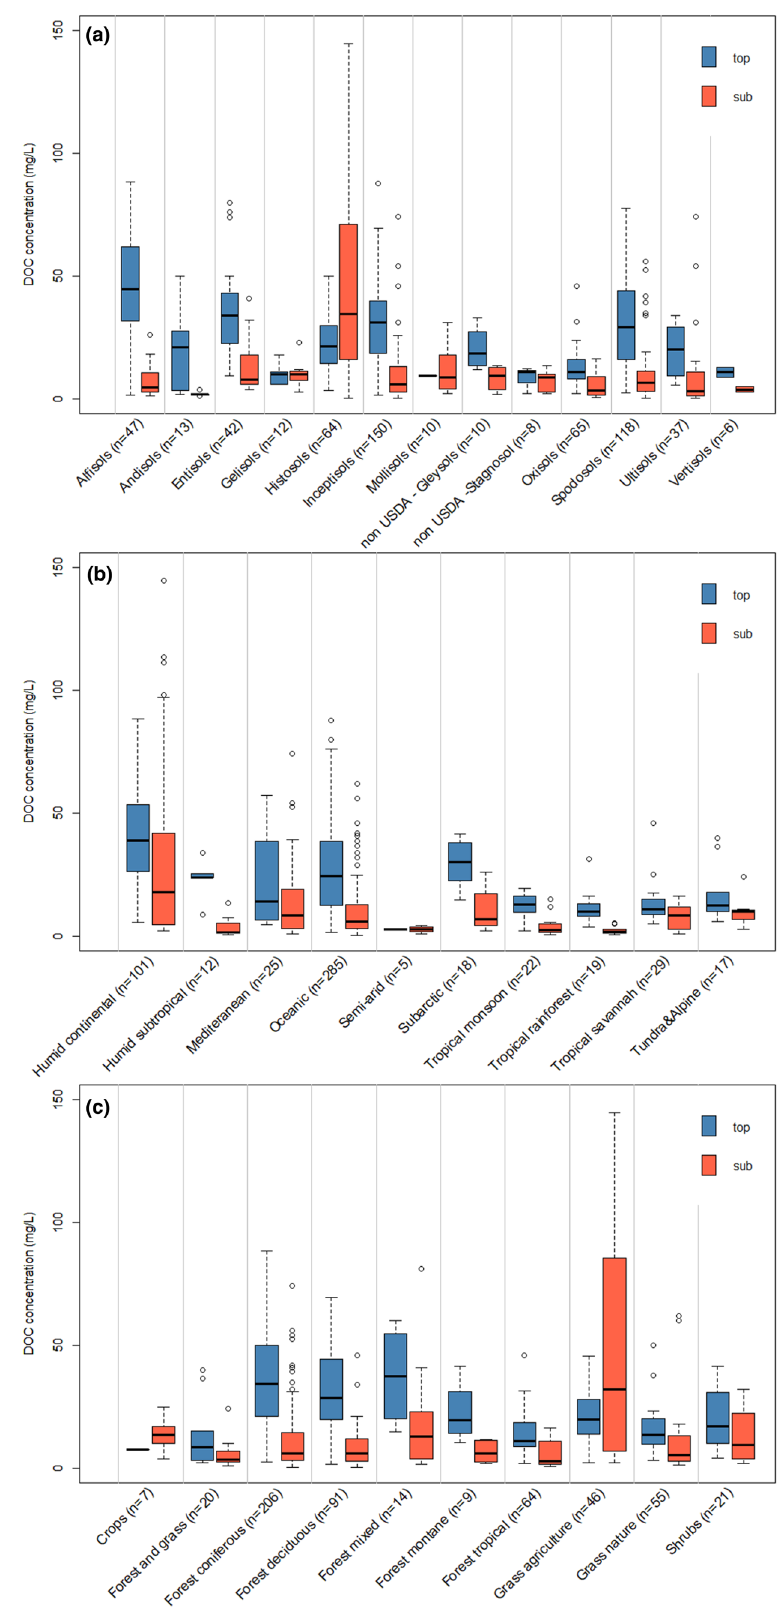
Fig. 5 Top and subsoil DOC concentration (mg C L −1 ) data distributed over a USDA soil classes, b sub-climate zones according to [54] and c land cover groups. Laboratory incubation data are excluded, n = 533. Boxplot bars are medians. Whiskers extend up to 1.5 times the interquartile range (IQR) from the lower and upper quartile, unless exceed- ing the minimum or maximum. Circles are values exceeding the whiskers. Two subsoil values (up to 372 mg C L −1 ) from Histosols are not shown, but included in the distribu- tion. In a , data for soils with a double or mixed classification is represented in both single classes. See SI 3 for similar distributions as for b , c , but excluding